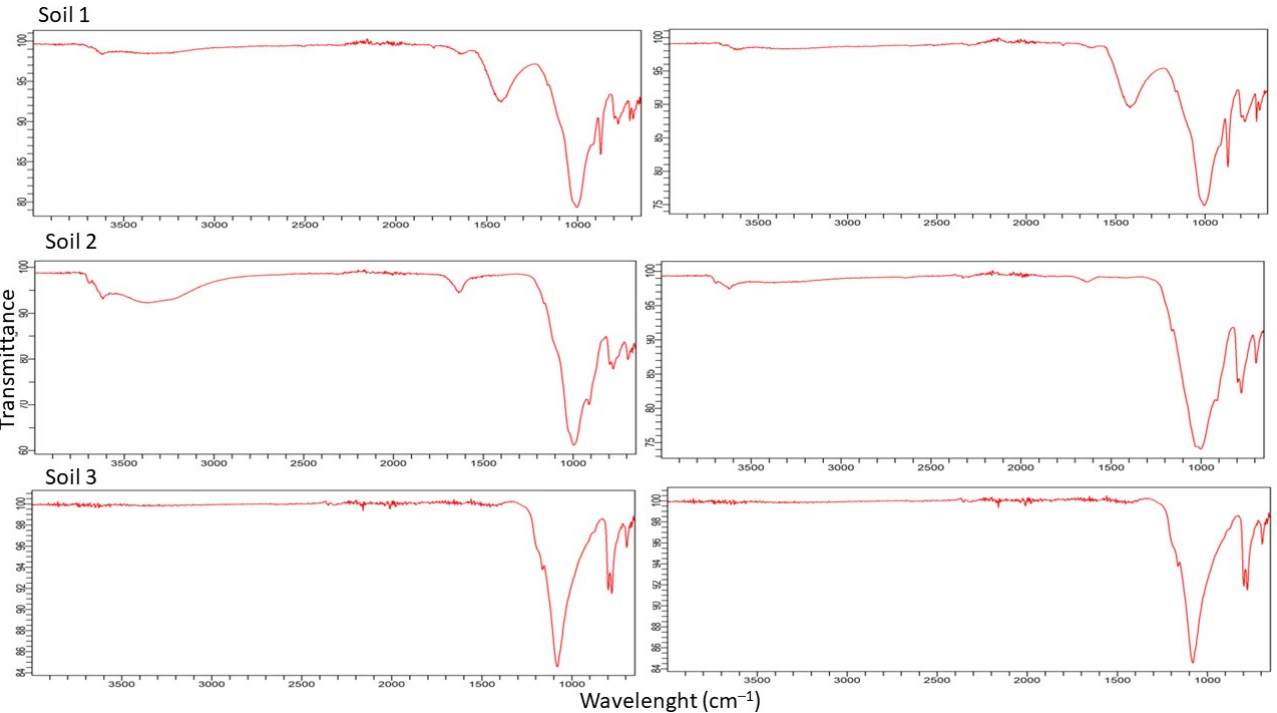
Figure 2. FT-IR transmittance spectra of three soils before ( left ) and after ( right ) the adsorption pro-